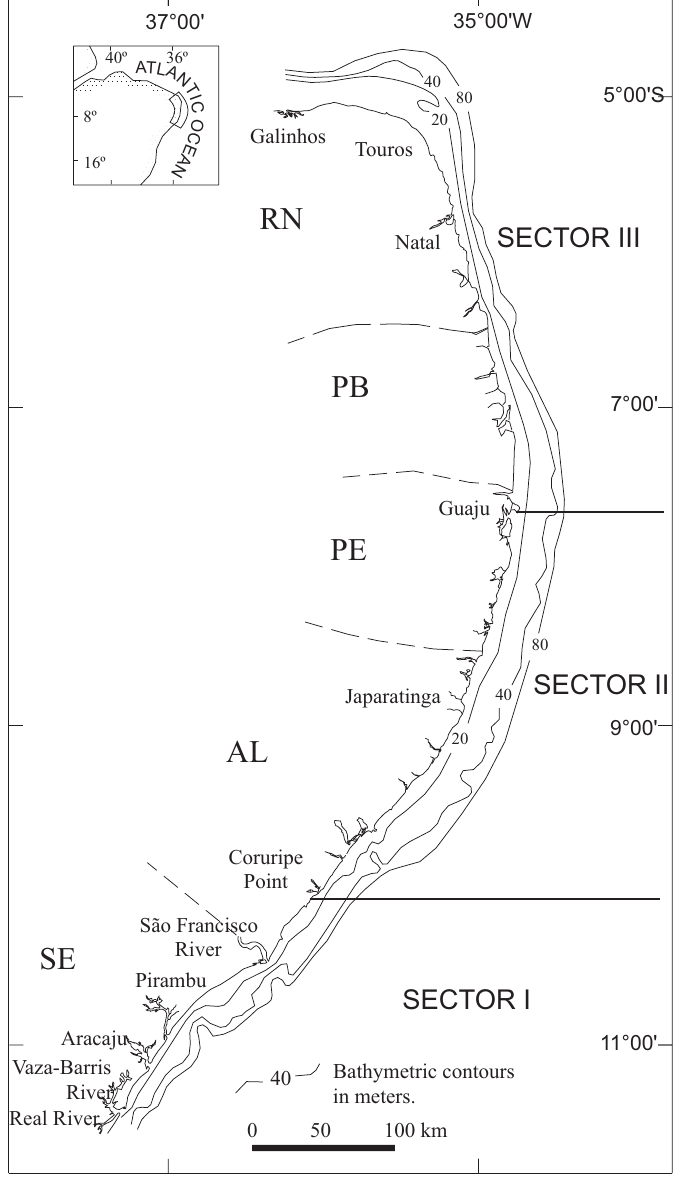
tical charts. The following wave-front directions were considered for the refraction diagrams: